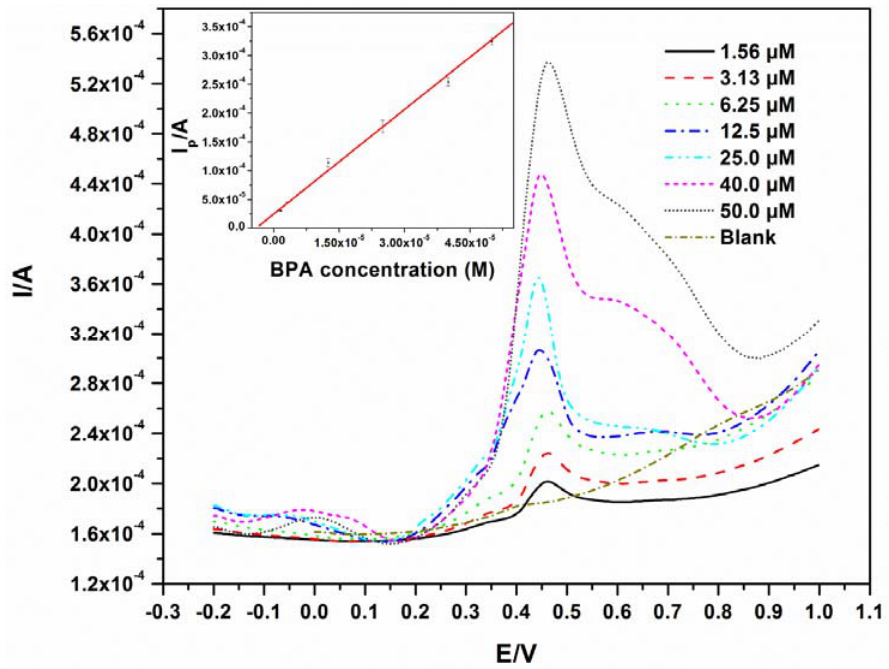
Figure 4. SWVs of different concentrations of BPA performed at an amplitude of 50 mV and a frequency of 25 Hz. Inset: linear variation of SWV currents with BPA